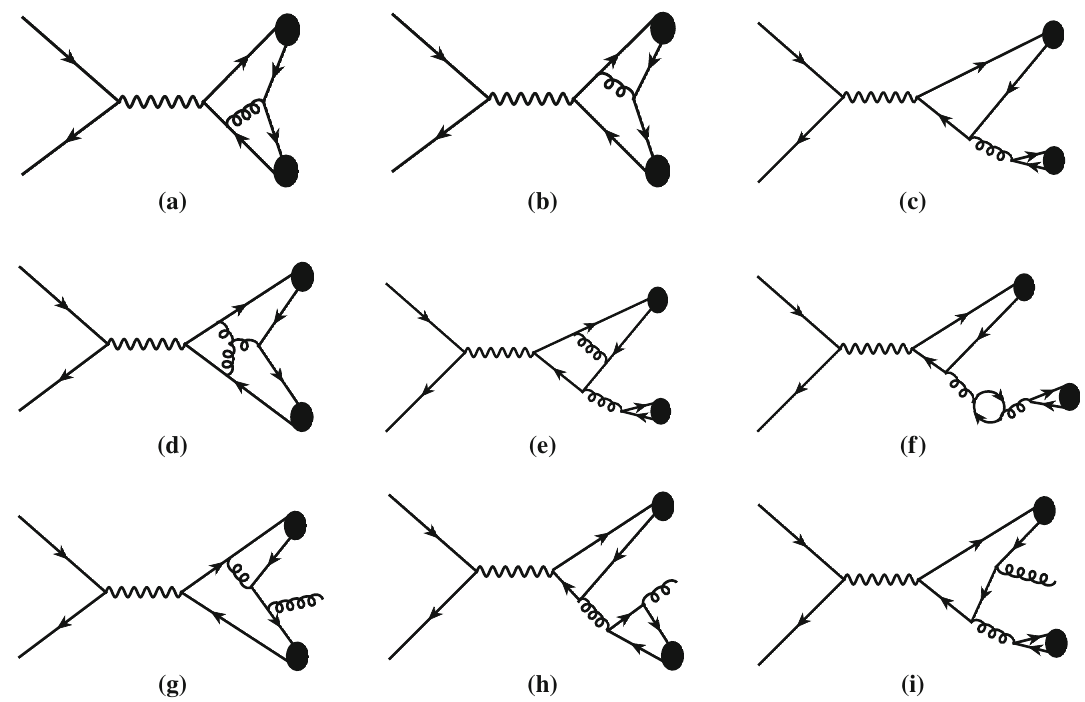
Fig. 1 Representative Feynman